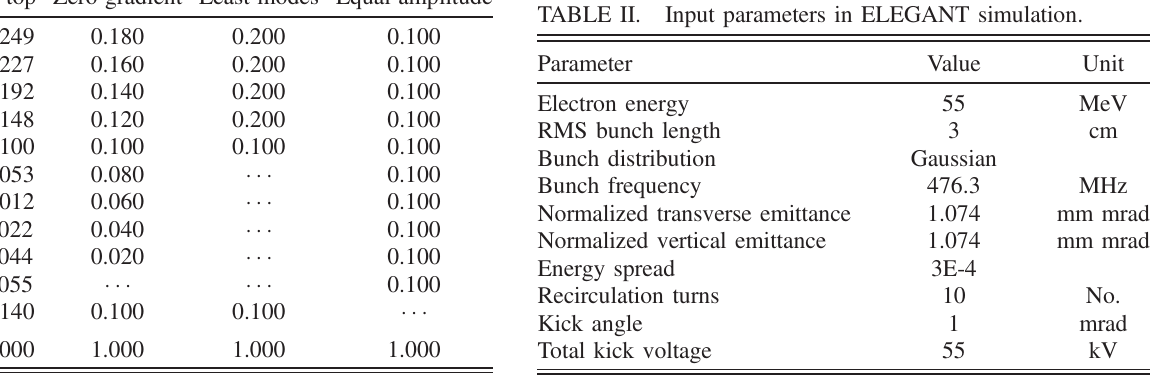
TABLE I. Normalized kick amplitude for each harmonic. Mode